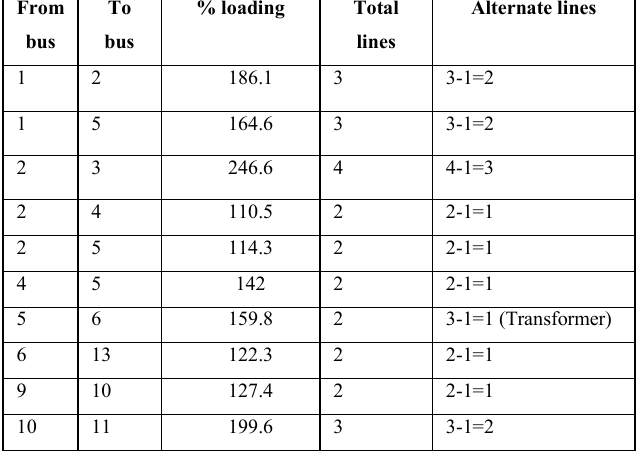
TABLE 1. ADDITIONAL LINES NEEDED WITH 60% LOAD INCREMENT AND DISTRIBUTION GENERATION AT BUS